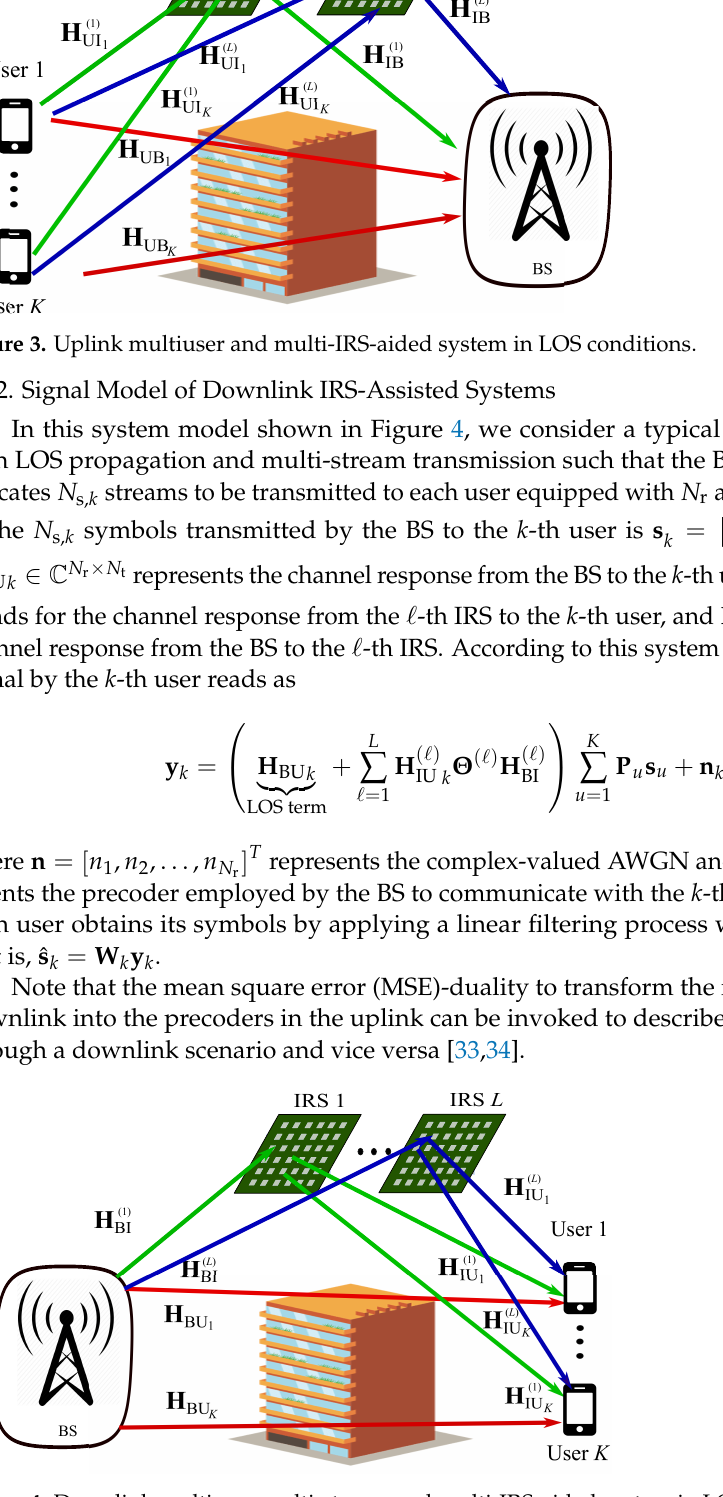
Figure 4. Downlink multiuser multi-stream and multi-IRS-aided system in LOS